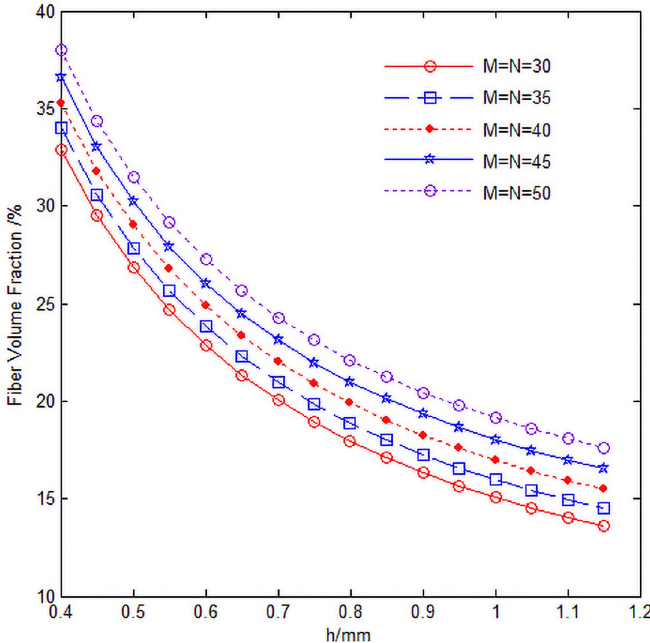
Fig 16. Relationship curve of fiber volume content V f , knuckle length h and yarn number.